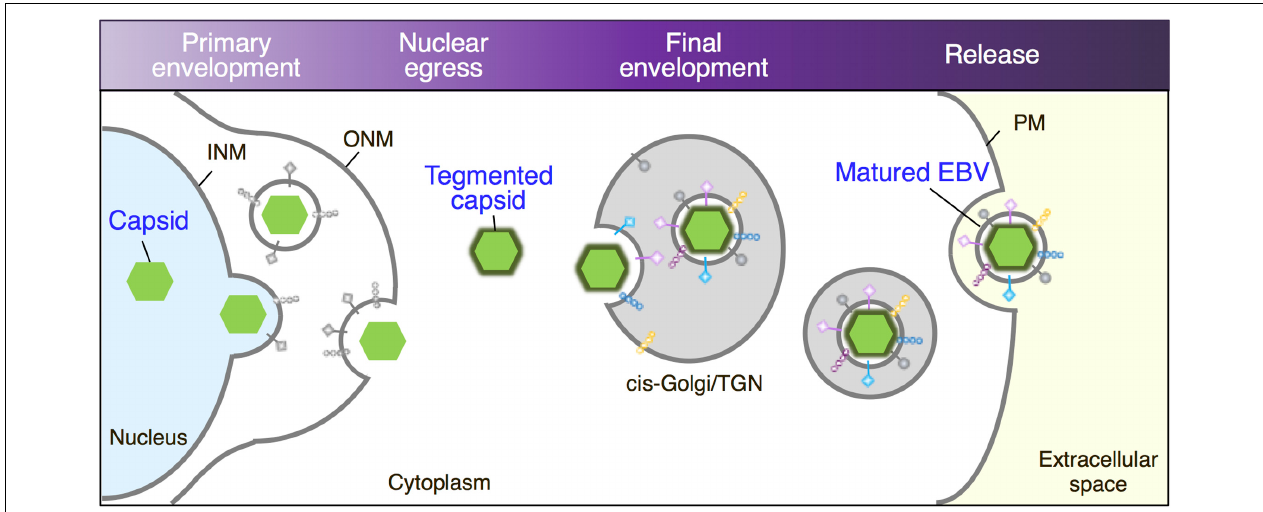
FIGURE 9 | Maturation of EBV virions. Replicated viral DNAs are packaged into capsids in the nucleoplasm. Nucleocapsids acquire primary envelopes by budding through the INM into the perinuclear space. Perinuclear enveloped virus particles undergo de-envelopment, which is mediated by membrane fusion between their primary envelope and the ONM (Nuclear egress). Tegument-coated nucleocapsids then undergo a final envelopment by budding into intracellular compartments derived from cis- Golgi/TGN, which produce mature virions in these compartments. Vesicles containing mature virions are then transported to the cell surface, fused with the PM to release virions into extracellular